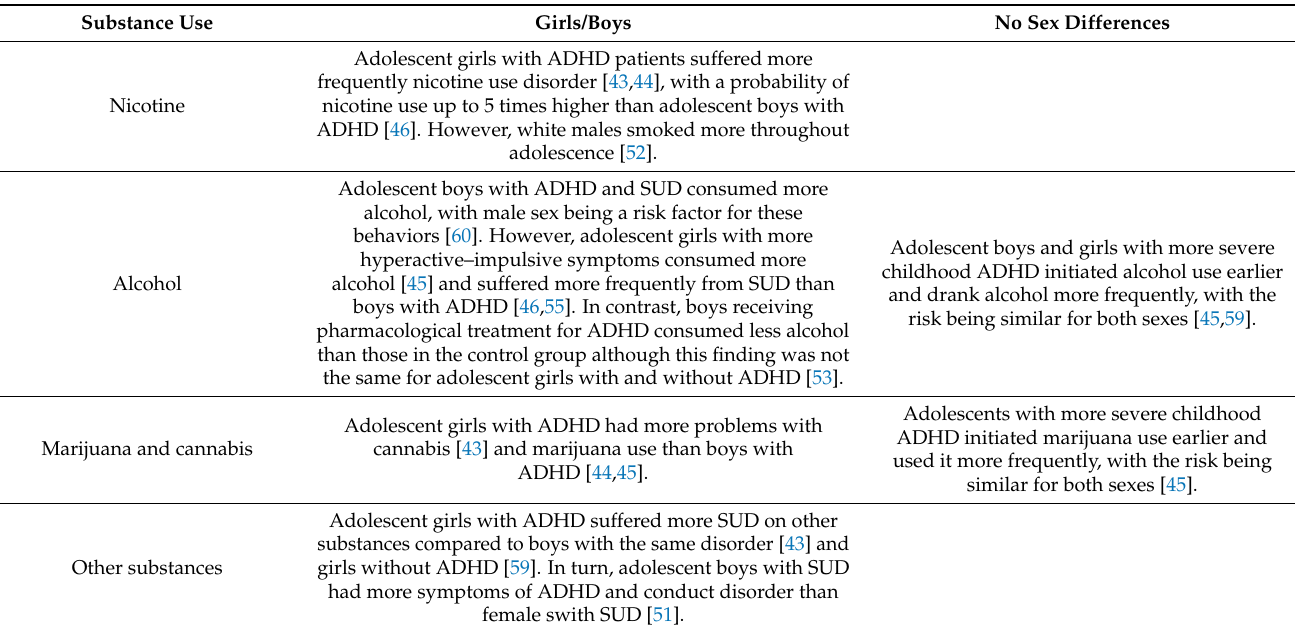
Table 2. Sex differences in substance use and substance use